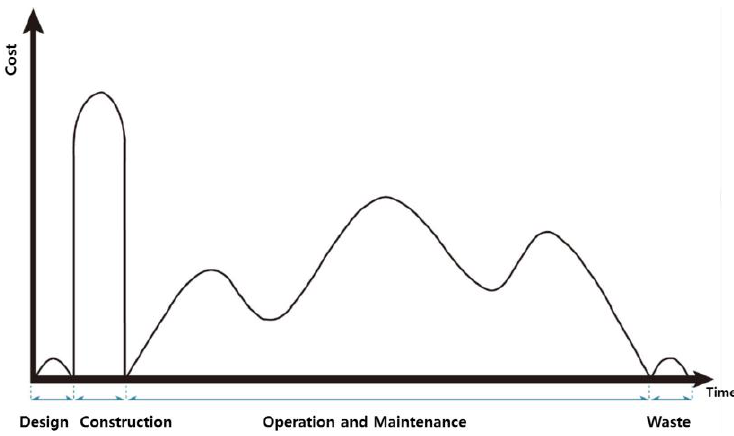
Figure 2. Cash Flow during Life Cycle of Buildings.